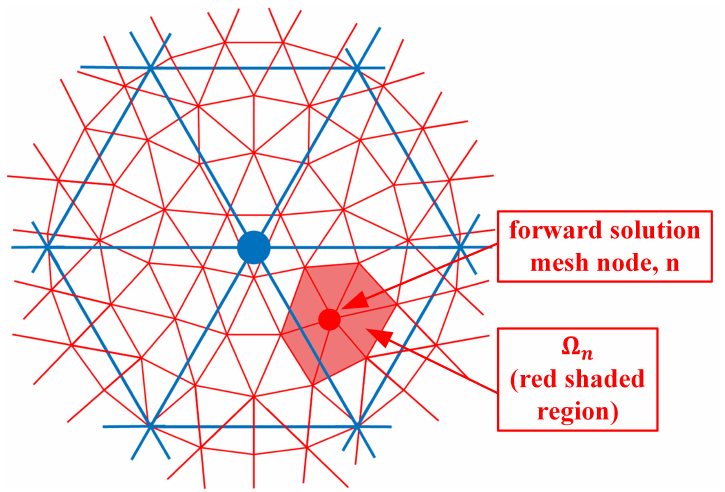
Figure 2. Forward solution mesh nodes; example of node n and corresponding region Ω n is sketched.